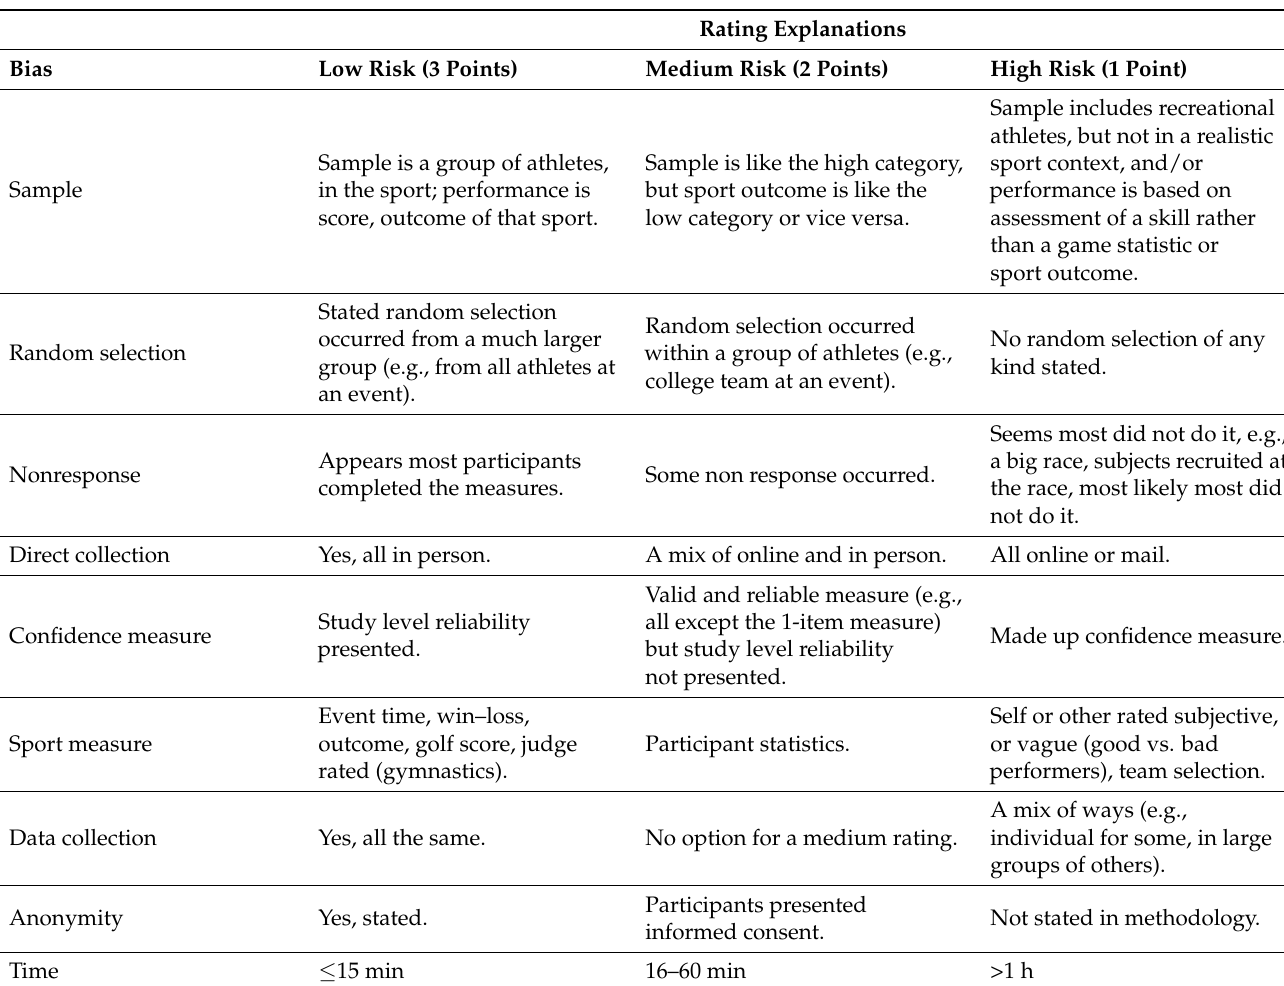
Table 1. Risk of individual study bias questions and rating